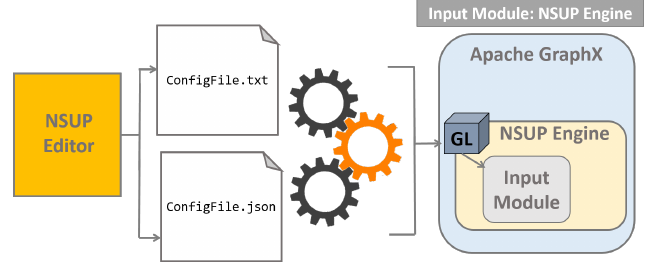
Figure 3. NSUP editor and Input module components.